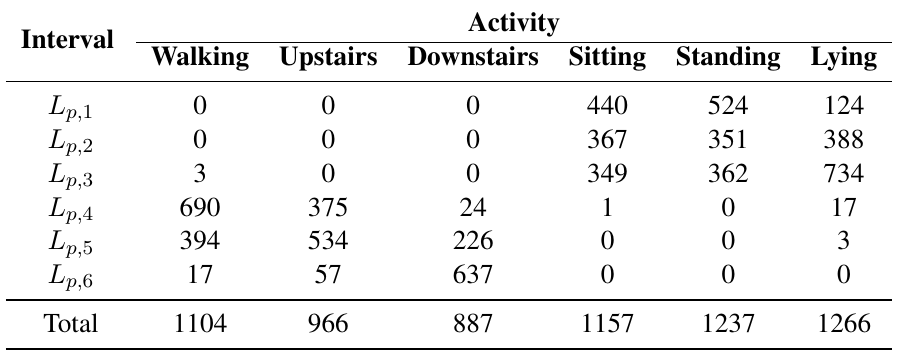
Table 5. Example of class matrix V for 6 discretization intervals and 6